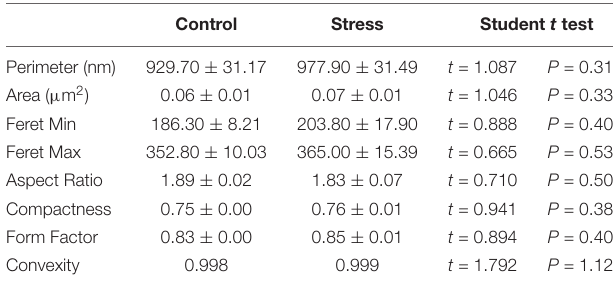
TABLE 1 | Comparisons of mitochondrial